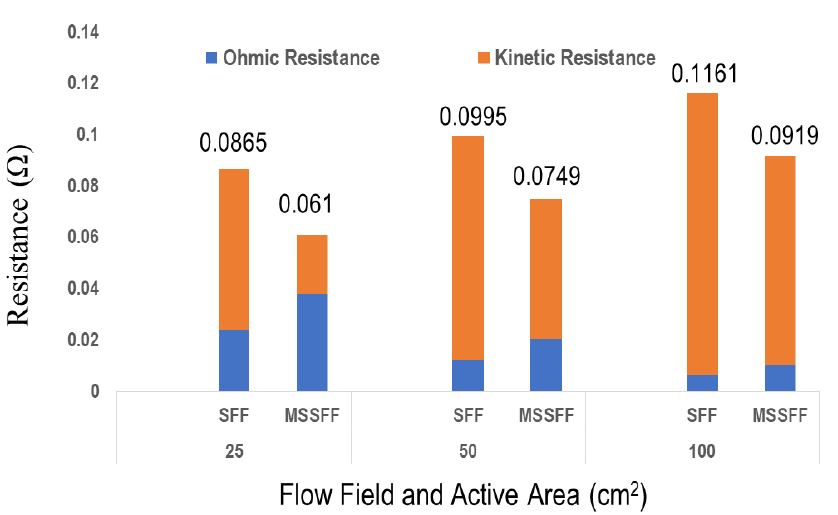
Figure 13. Resistances obtained from EIS studies for PEMFCs with reaction areas of 25, 50 and 100 cm 2 employing SFF and MSSFF.